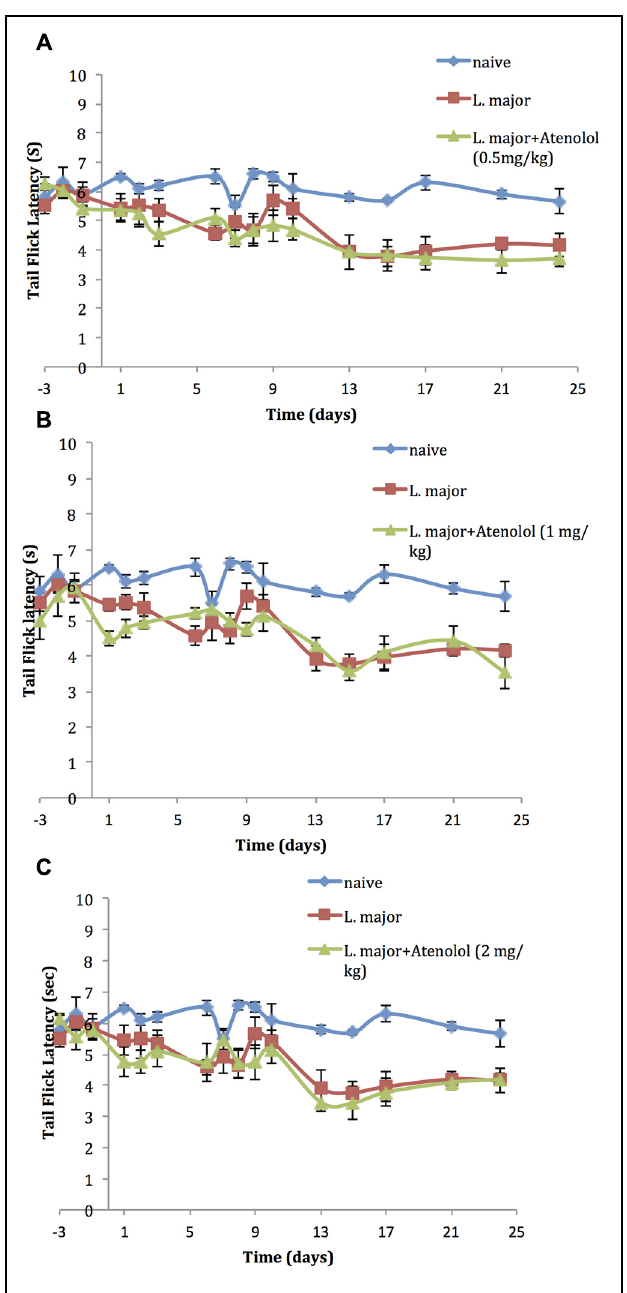
FIGURE 5 | The time course of the effect of the daily i.p. injection of Atenolol on L. major (high dose) induced hyperalgesia as assessed by the TF test. Mice were injected with 4 × 10 6 promastigotes per 50 μ l per left hind paw and three groups were also treated with Atenolol 0.5 mg/kg (A) , or 1.0 mg/kg (B) , or 2.0 mg/kg (C) for 7 consecutive days. Each result is the mean of 5 mice ± SEM and the degree of significance was calculated with reference to atenolol non-treated mice.